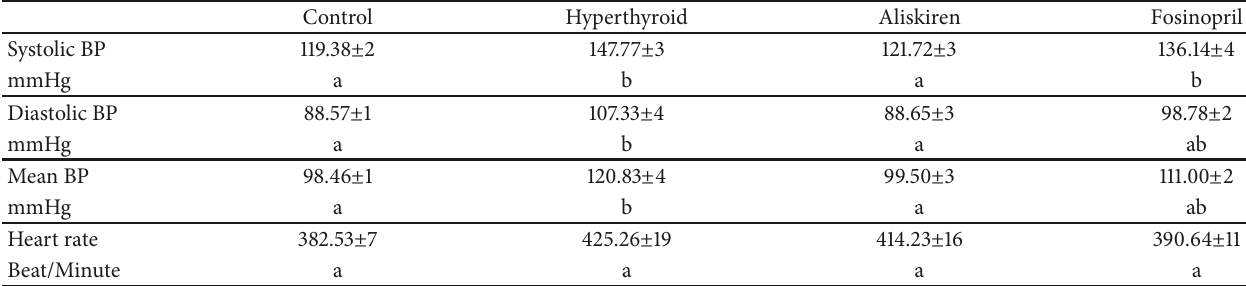
Table 4: The relation between blood pressure (BP) and heart rate in control, hyperthyroid, Aliskiren, and Fosinopril